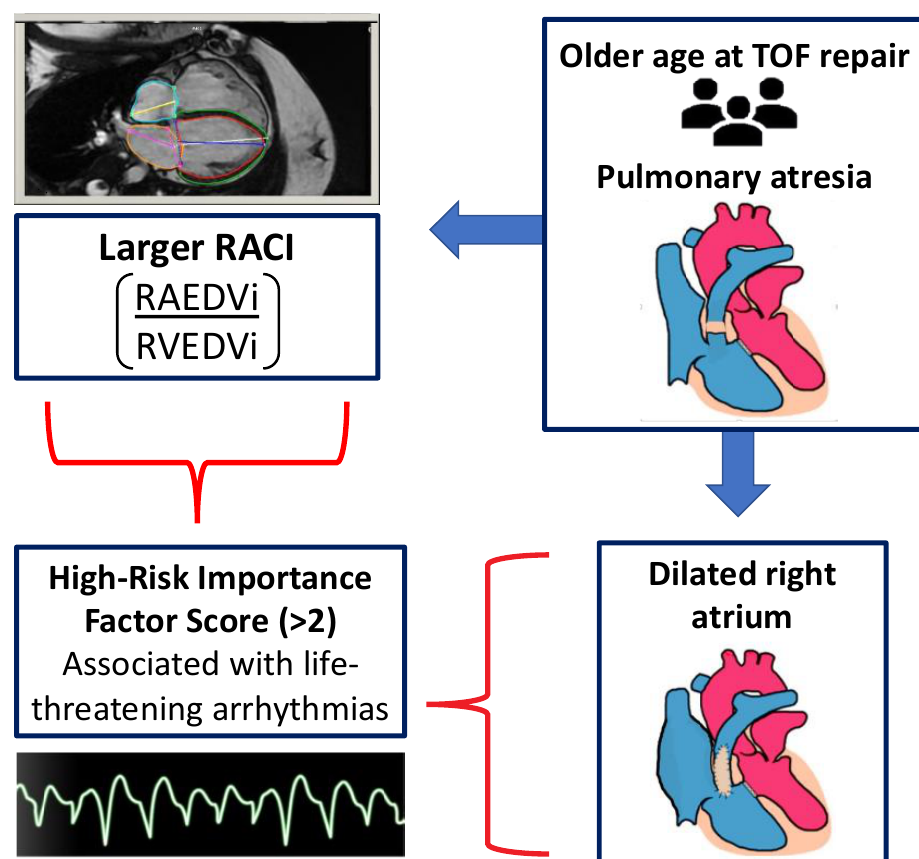
Figure 1. Visual abstract summarizing the primary findings of this paper. Diastolic dysfunction has emerged as an important predictor of adverse outcomes in multiple forms of congenital heart disease [7]. In rTOF, increased left ventricular end- diastolic pressure measured by cardiac catheterization is a known risk factor for ventricular tachycardia and sudden cardiac death [8]. Another important risk factor for sudden death in rTOF is atrial tachycardia, which may be secondary to atrial dilation [6]. Both atrial size and atrial function have been recognized as surrogate parameters for assessing diastolic dysfunction [9,10]. CMR provides important insights into the risk of adverse clinical outcomes in rTOF, and multiple risk scores have been developed based on a combination of clinical and CMR parameters. One such risk score is the “Importance Factor Score”, created by Atallah J et al. A high-risk Importance Factor Score was found to be associated with life-threatening arrhythmic events with a sensitivity of 88% and a specificity of 68% [11]. Another recently devised CMR prognostic tool, the left atrioventricular coupling index (LACI), has been evaluated as part of the Multi-Ethnic Study of Atherosclerosis (MESA) [12]. LACI is defined as the ratio between LA end-diastolic volume and LV end- diastolic volume. It was created to determine whether the close physiological relationship between the LA and LV could serve as a primary prevention tool in the early detection of cardiovascular disease. LACI has been shown to serve as a strong predictor for the incidence of heart failure, atrial fibrillation, cardiovascular disease, and coronary heart disease death in healthy adult populations [12–14]. A novel right atrioventricular coupling index can potentially help with risk stratification in patients with rTOF. There has been limited investigation intof the use of atrial measurements obtained via CMR for predicting outcomes in rTOF patients. Thus, we examined the relationship between left and right atrial volumes and function and ventricular parameters from